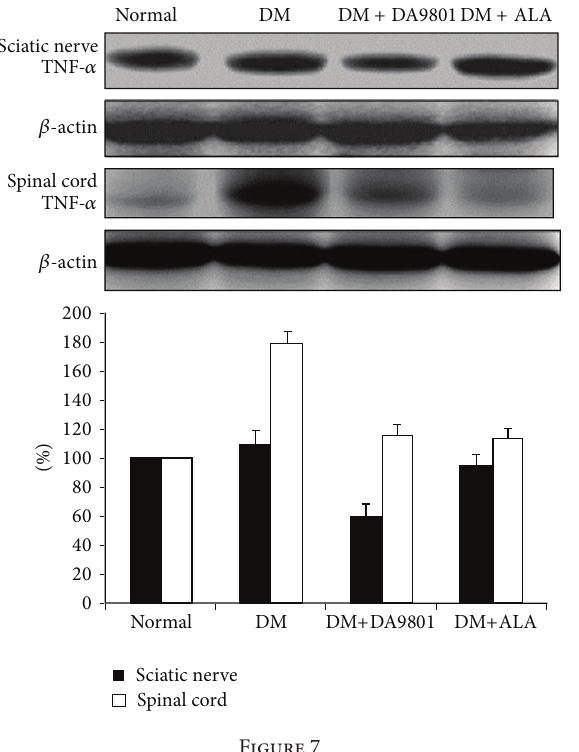
NGF, brain-derived neurotrophic factor, neurotrophin- (NT- ) 3, IGF-I, IGF-II, and glial cell-derived neurotrophic factors have also been examined as therapeutic agents [5,